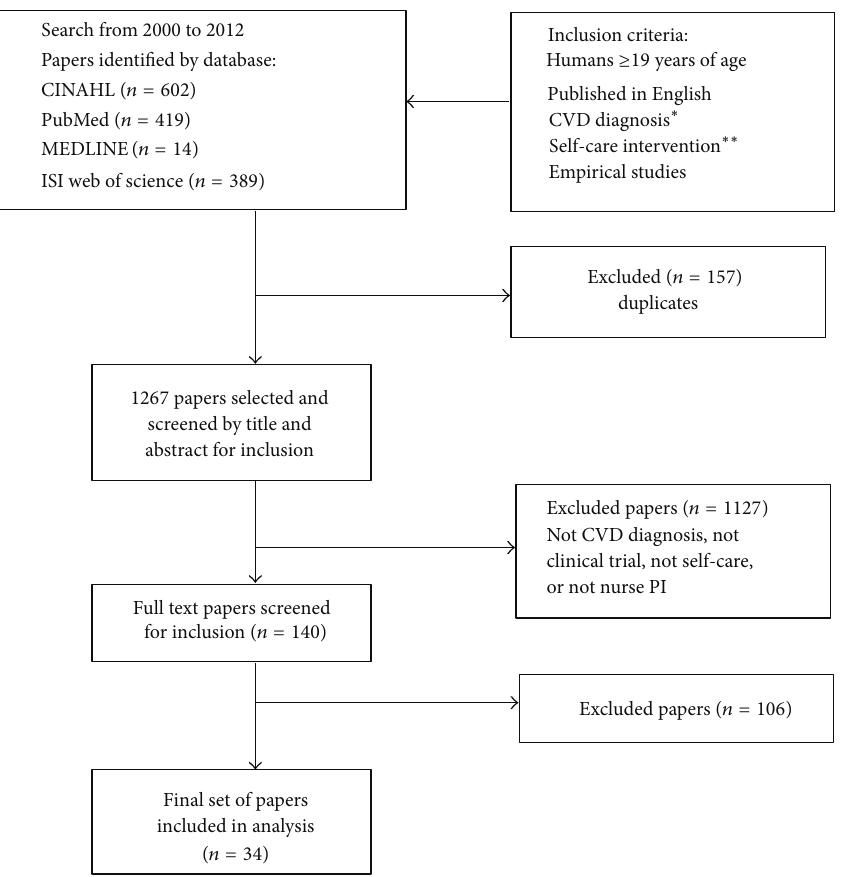
Figure 1: PRISMA flowchart. ∗ “cardiovascular disease,” “coronary heart disease,” “coronary artery disease,” “heart disease,” “congestive heart failure,” “heart failure,” “hypertension,” “cerebral vascular disease,” “stroke,” “peripheral vascular disease,” “vascular disease,” “arrhythmia.” ∗∗ “self-care,” “self-management,” “self-care maintenance,” “self-care management,” “symptom management,” “symptom monitoring,” “adherence,” “compliance” AND “intervention” OR